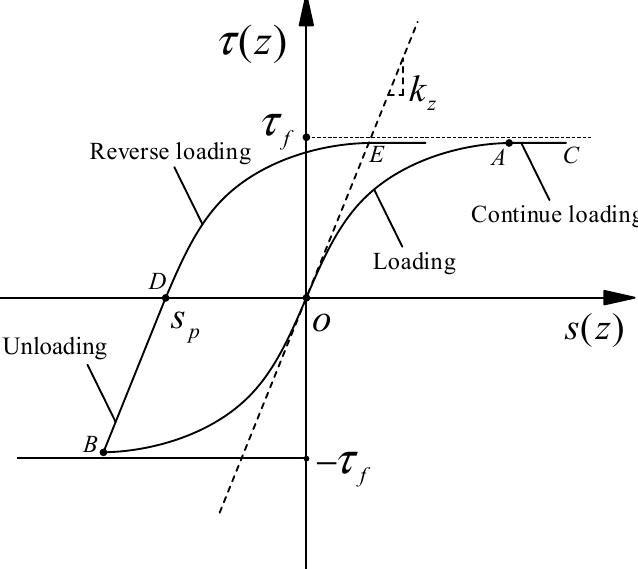
Figure 3. Load transfer curve of pile–soil interface under vertical load.